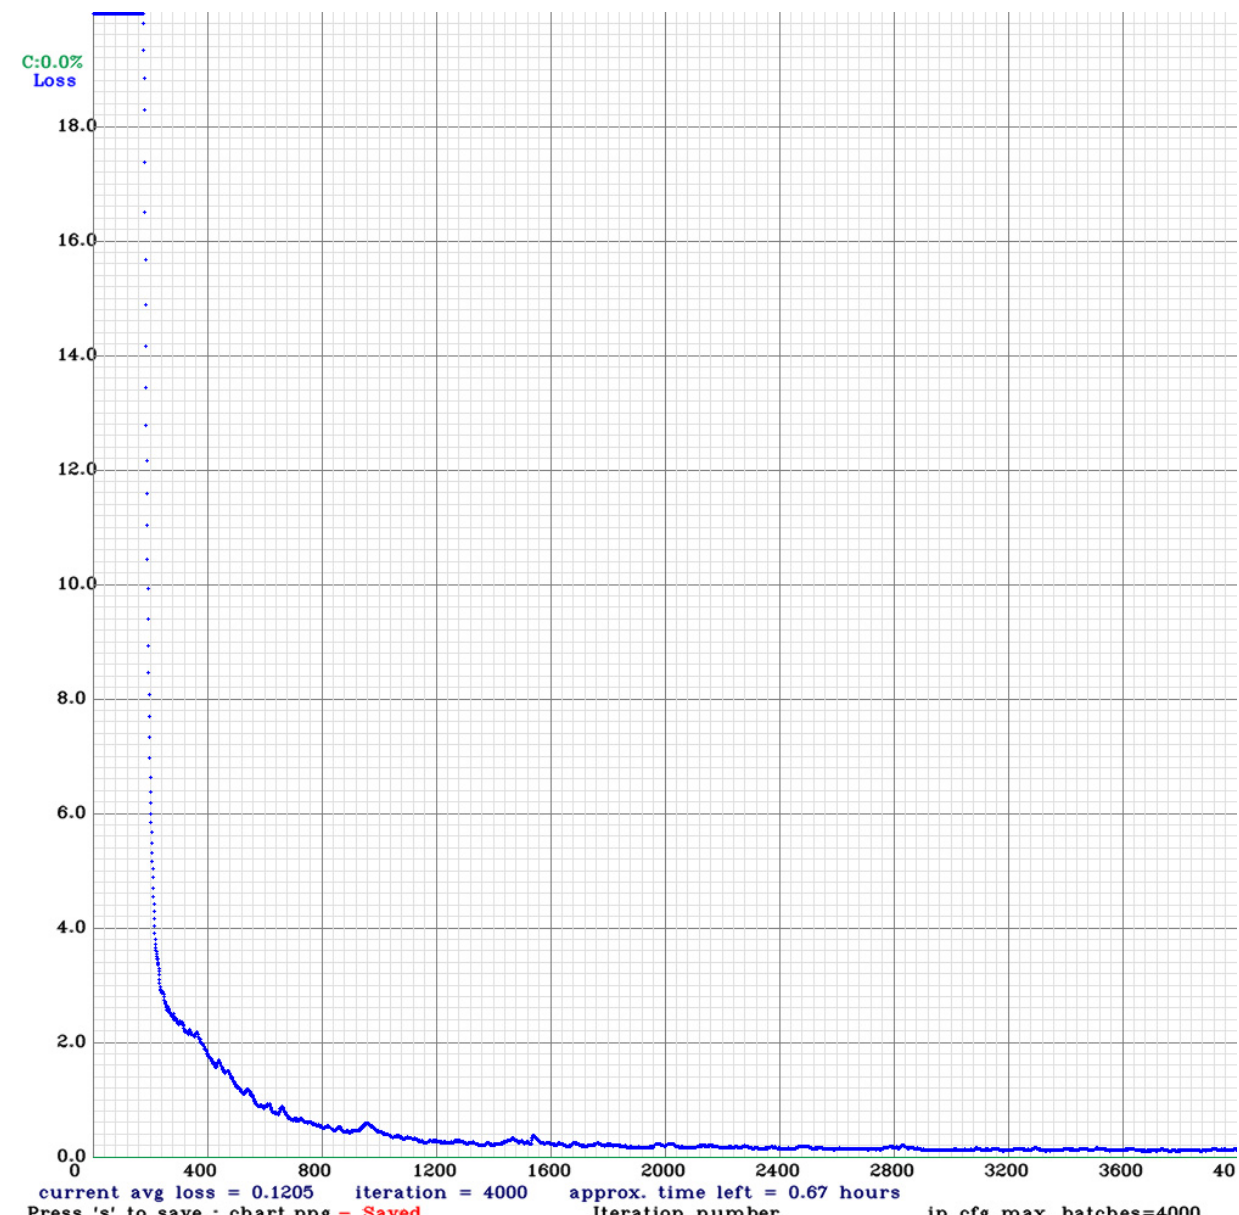
Figure 5. Simulation of coal gangue separating robot system.